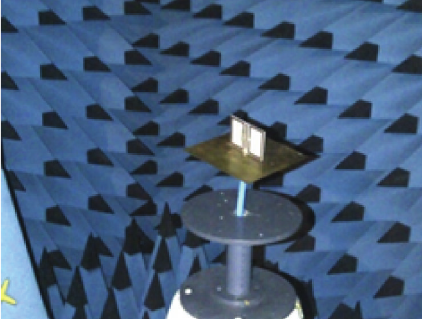
Figure 14: Photo of the realized prototype of the two-CLL element reconfigurable antenna.